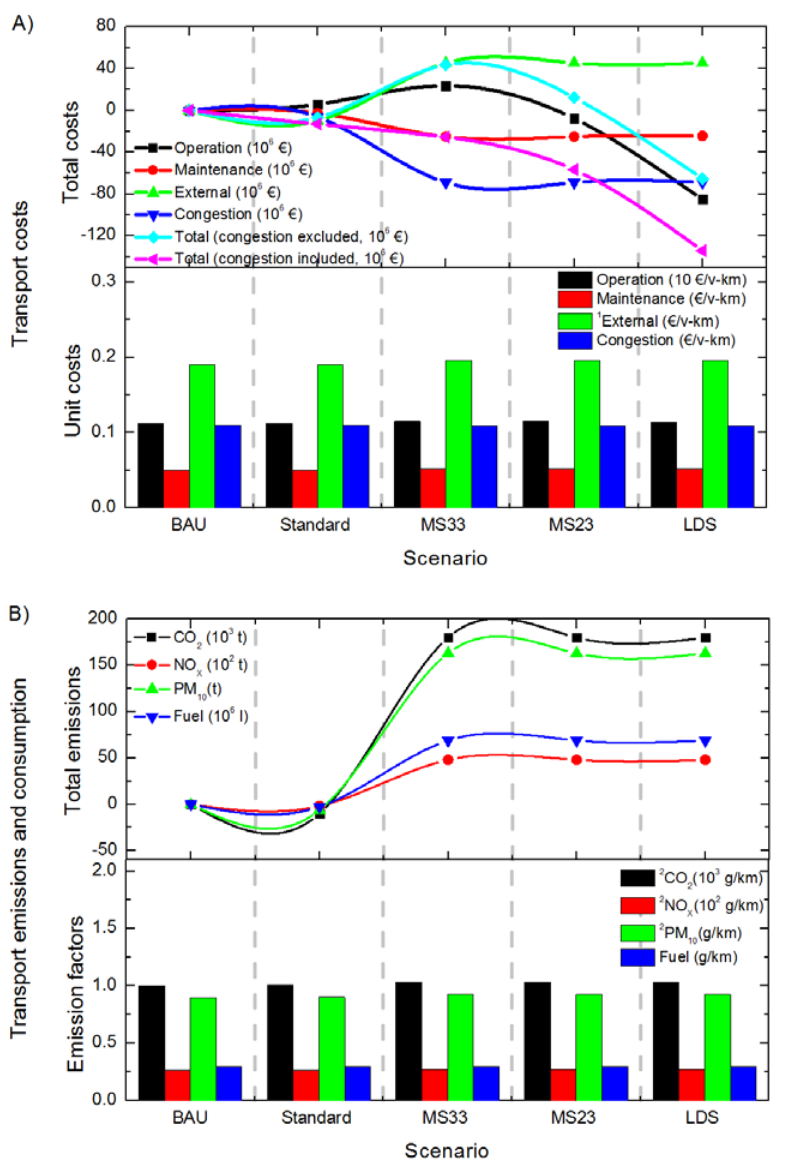
Figure 4. Road freight transport costs and emissions. A) Operation, maintenance, external, and congestion cost balances of the aggregated freight road transport according to substitution scenarios (10 6 €, 2008 constant prices). B) CO 2 (10 3 t), NO X (10 2 t), PM 10 (t) emissions and fuel consumption (10 6